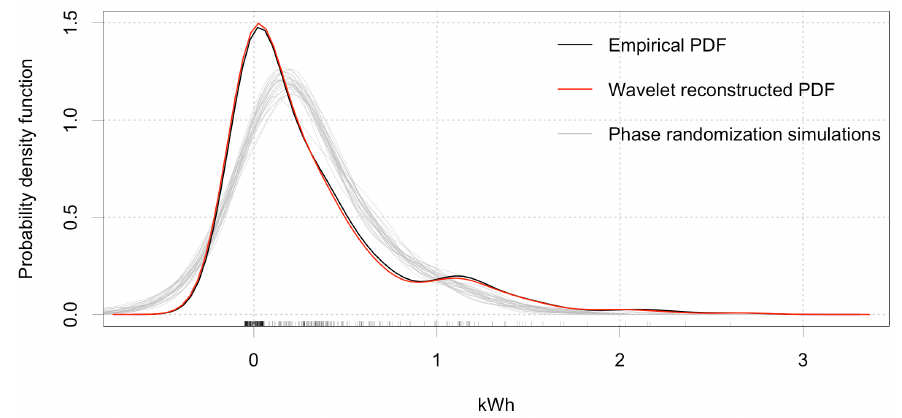
Figure 11. Simulation of the wavelet decomposed 5 a.m. hourly energy usage by DHW heater in RBSA home 13088 from Q2 2012–Q1 2013 inclusive, using the phase randomization method.